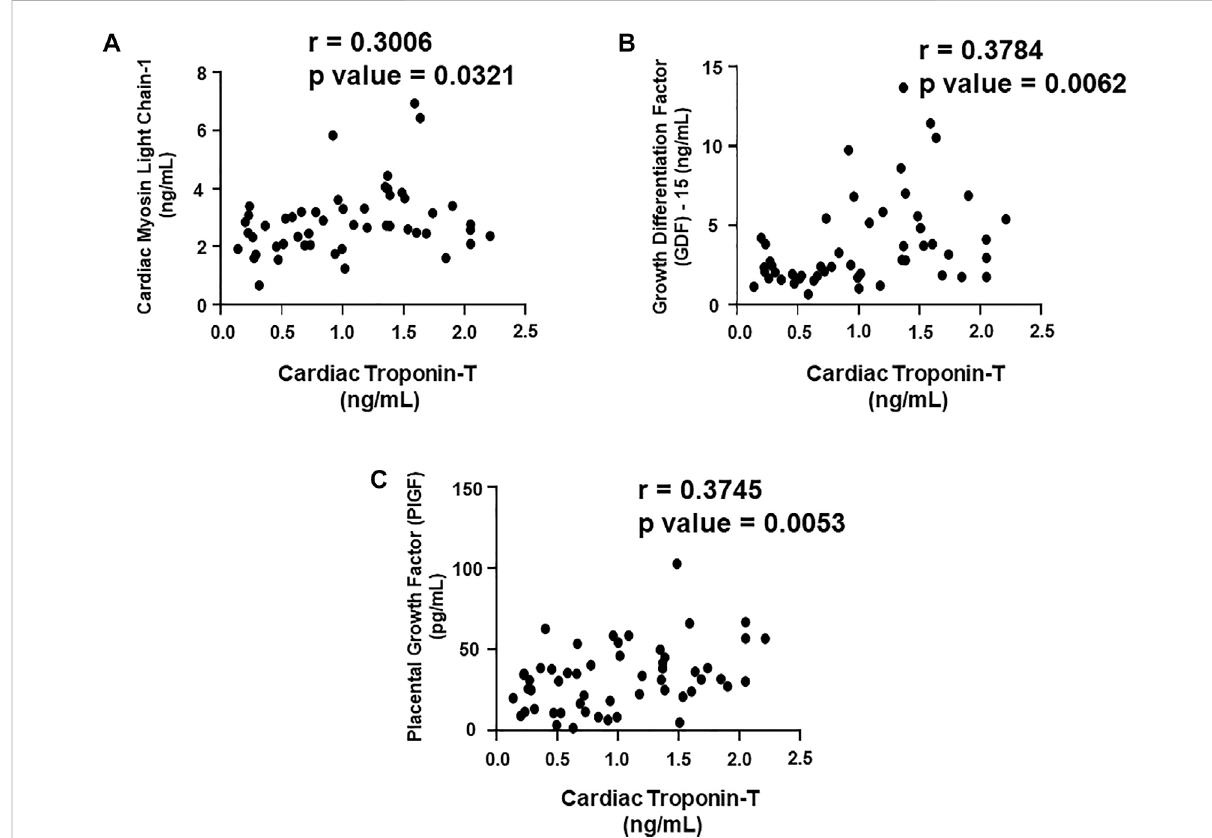
FIGURE 5 Correlation analysis of cardiac troponin T with plasma biomarkers. Correlation analysis was performed using a scatter plot between cardiac troponin T and plasma biomarkers, (A) cardiac myosin light chain 1 (cMLC1), (B) growth differentiation factor 15 (GDF-15) and (C) placental growth factor (PIGF). Pearson ’ s r coef fi cient was used to determine the extent of correlation and statistical signi fi cance was obtained by two-tailed p -value. Each plot independently demonstrates the correlation (Pearson ’ s r coef fi cient) and signi fi cance ( p —